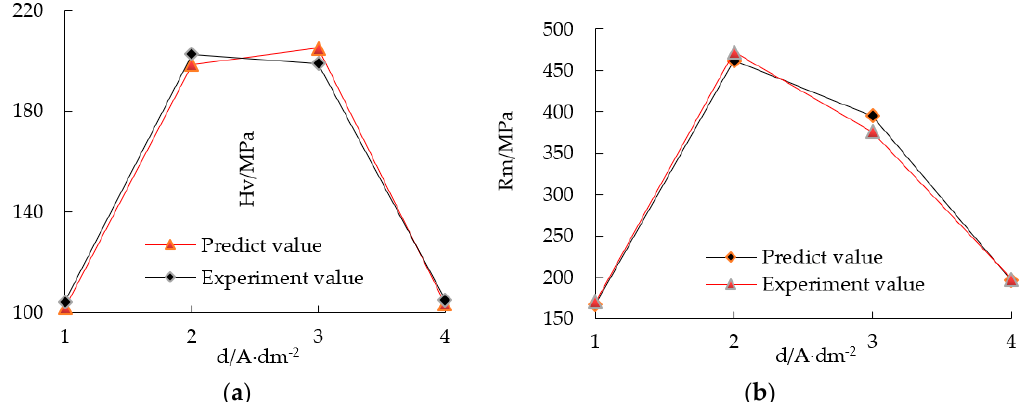
Figure 4. Comparison between the experimental and predicted values with different current density. ( a ) Microhardness and ( b ) tensile strength.